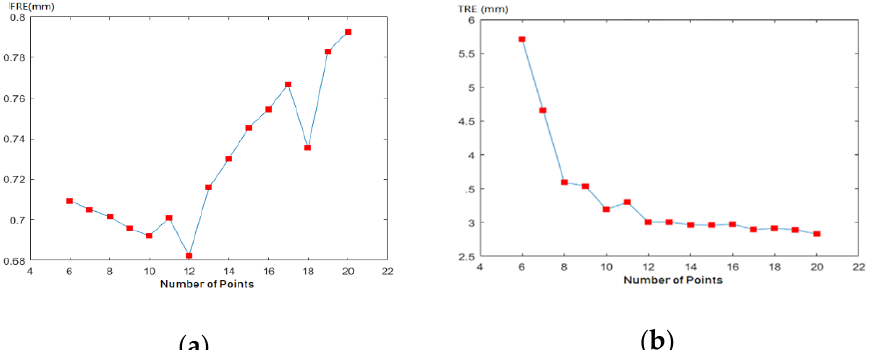
Figure 5. Relationship between number of fiducial points and spatial calibration errors: ( a ) relationship between number of fiducial points and FRE; ( b ) relationship between number of fiducial points and TRE.